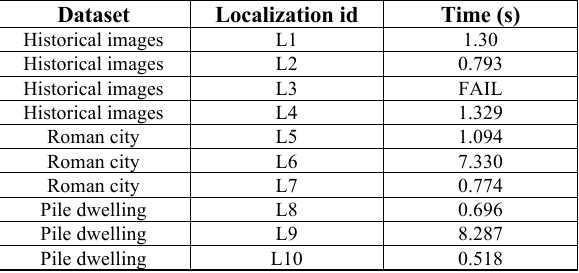
Table 2 . The different case studies and the time (sec) required to localize the user from the start of the AR